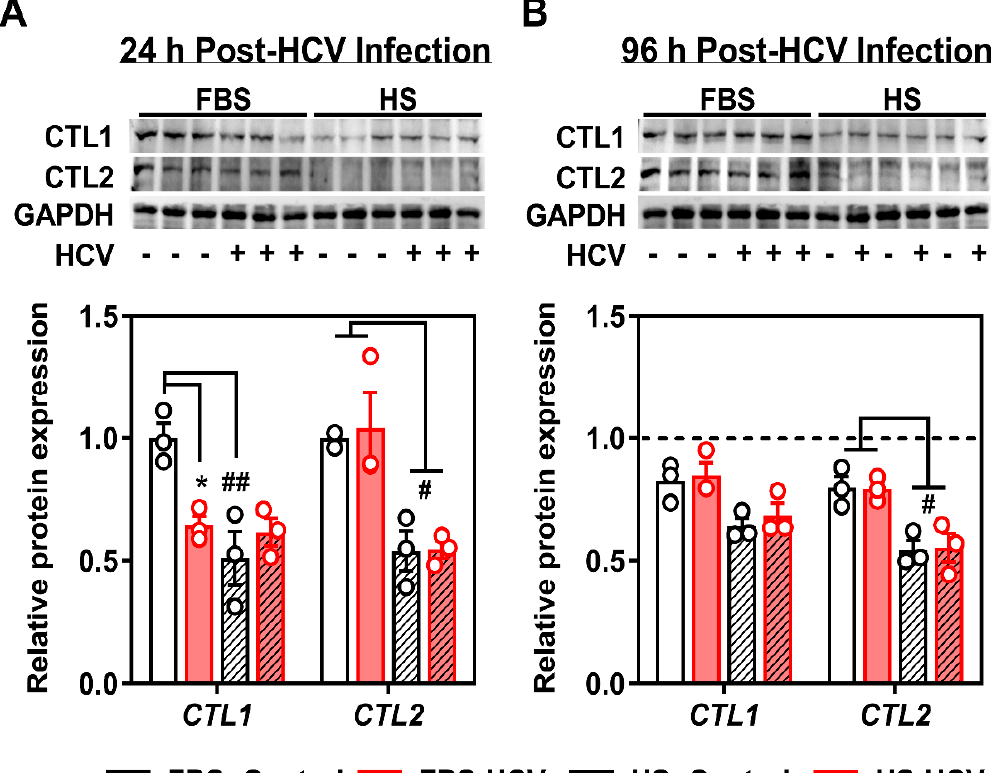
Figure 3. Choline transporter protein expression at 24 h and 96 h post-HCV infection. FBS- and HS-cultured Huh7.5 cells were infected at an MOI of 1 for ( A ) 24 h or ( B ) 96 h before cells were washed and protein isolated to measure choline transporter (CTL1; choline transporter-like 1 and CTL2; choline transporter-like 2) total protein expression. Samples were run on two individual gels, but transferred to a common membrane. Densitometry analyses depicts the density of CTL1 and CTL2 normalized to GAPDH and shown relative to uninfected FBS-cultured control cells at 24 h. The hashed line in ( B ) represents the level of uninfected FBS-cultured control cells at 24 h. Data are mean ± SEM and represent three independent experiments. Statistical significance was determined by two-way ANOVA with a Tukey post-hoc analysis (within each protein), such that * represents p < 0.05 compared to uninfected control within serum culture condition, and # and ## represents p < 0.05 and p < 0.01 compared between FBS- and HS-cultured conditions, respectively.